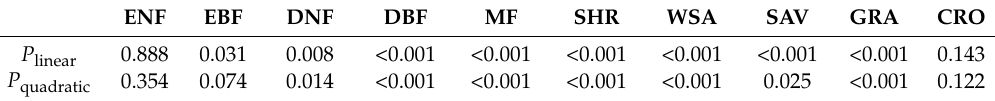
Figure 3. The dynamics of NDVI from 1982–2013 and the heat responses of NDVI to elevated temperatures (red line—quadratic function; black line—linear function) for various vegetation biomes. Table 2. Significance levels ( p- value) for heat responses of NDVI to elevated temperatures ( P linear —linear function; P quadratic —quadratic function) for various vegetation biomes.